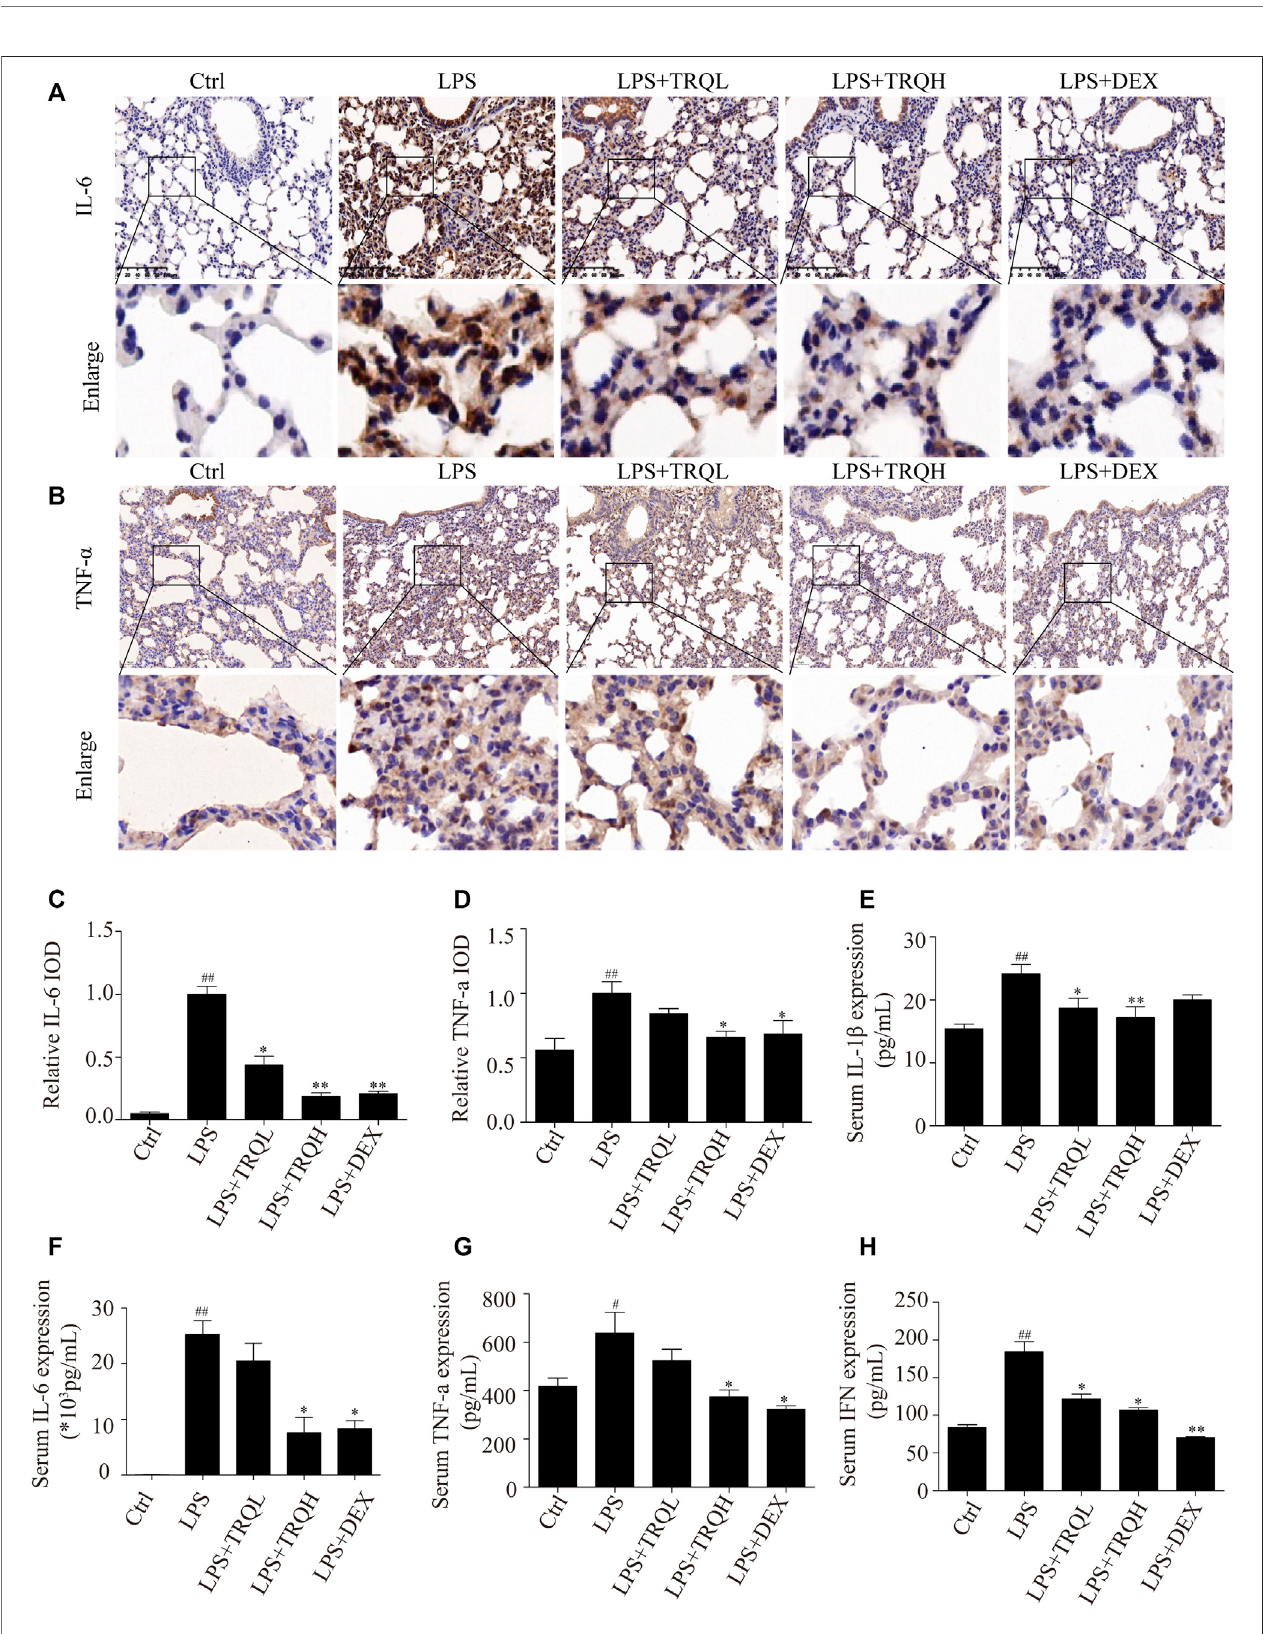
FIGURE4| TRQdecreasedin fl ammatorymediatorproductioninLPS-induced ALImice. (A – D) Representativeimagesand quantitative analysisofIL-6andTNF- α inlungtissues. (E) ThelevelsofIL-1 β inserum. (F) ThelevelsofIL-6inserum. (G) ThelevelsofTNF- α inserum. (H) ThelevelsofIFN- β inserum. n (cid:2) 5 – 6. ## p < 0.01vs.Ctrl group; *p < 0.05 and ** p < 0.01 vs. LPS group, respectively.